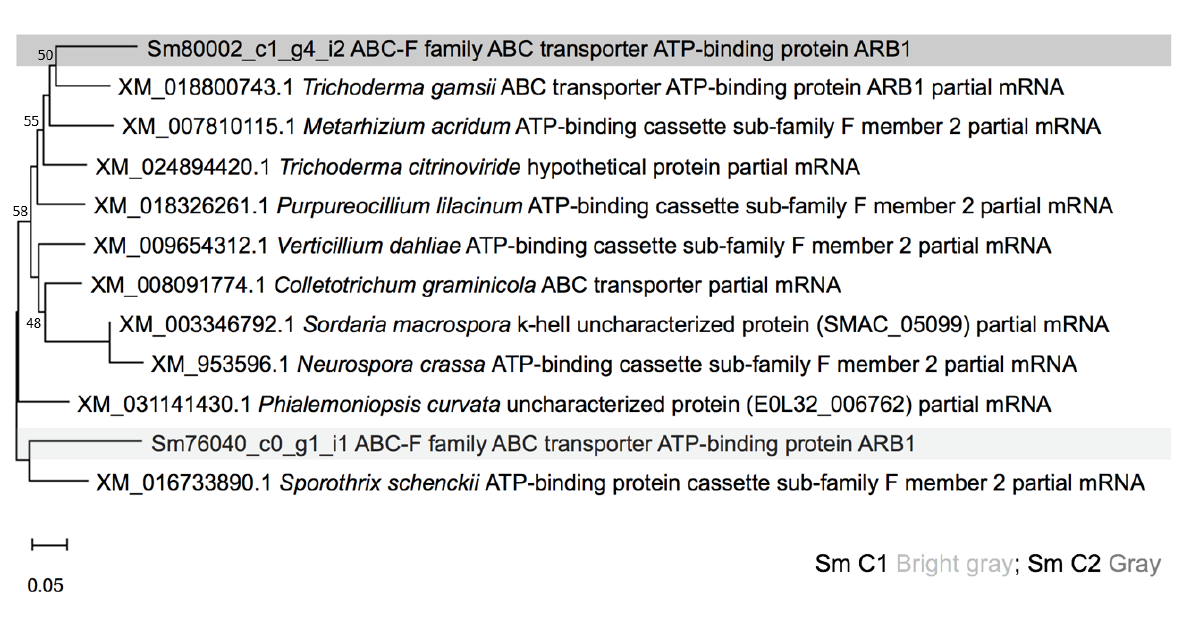
Figure 7. The unrooted phylogenetic tree for the ABC-F family transporters in S. mycoparasitica was built with MEGA-X by using the minimum evolution method [39]. The branch support bootstrap (>50%) values were obtained by 1000 replicates using the NJ method. Sm C1 (bright gray color) and Sm C2 (gray color) represent S. mycoparasitica incubated for 1.5 and 3.5 days, respectively, without interaction with the host.